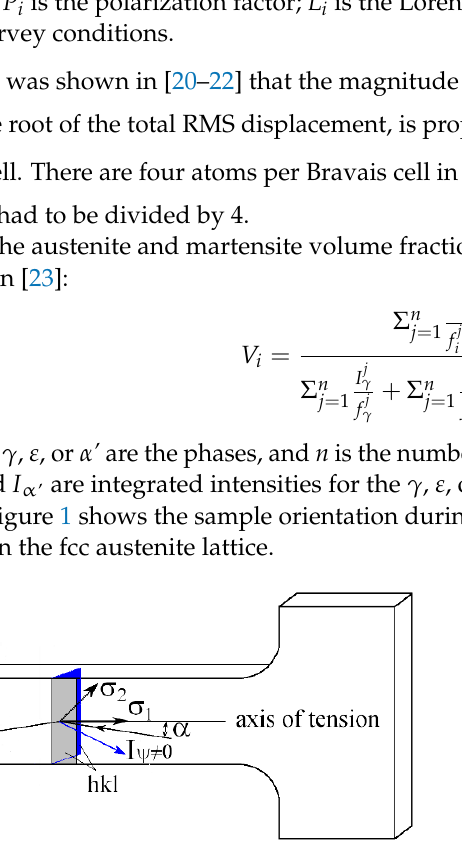
Figure 1. The scheme of the sample orientation during the study of residual oriented deformations in the fcc austenite lattice by the XRD sin 2 ψ method: α is the X-ray incidence angle; I ψ = 0 and I ψ ≠ 0 are the directions of the X-ray reflection in the Bragg–Brentano and asymmetric geometries, respectively; σ 1 and σ 2 are the directions of residual stresses associated with the oriented micro- deformations; hkl are crystallographic planes in the Bragg–Brentano (light gray) and asymmetric (dark blue) geometries.